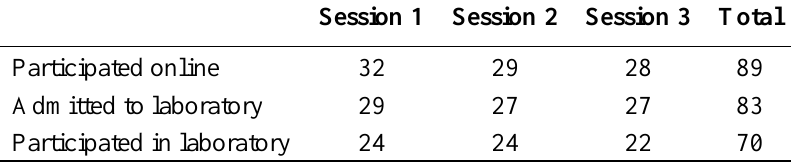
Table 2. Participants in the